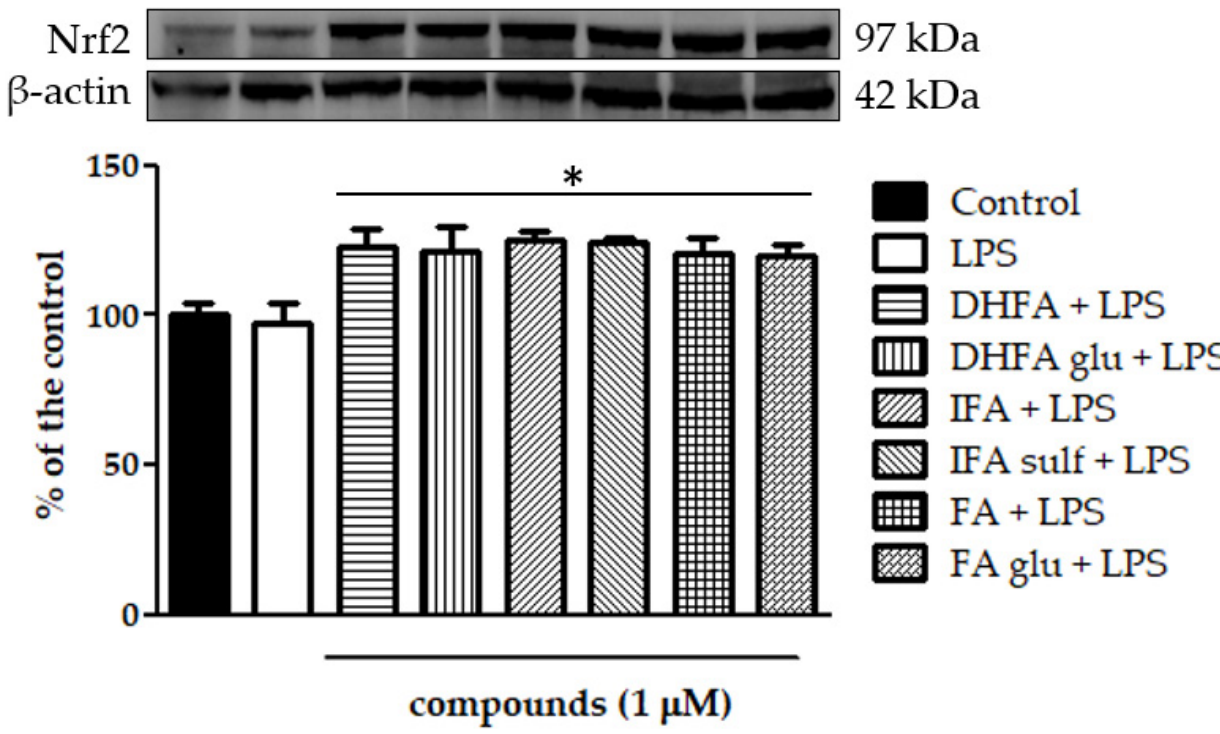
Figure 10. Level of Nrf2 dosed by Western blot and reported as a percentage of the control in Caco-2 cells treated with LPS (1 µ g/mL) for 48 h and pretreated for 30 min with FA, DHFA, IFA, FA glu, DHFA glu, and IFA sulf (1 µ M) preceding LPS co-exposure. Control and LPS groups were pretreated with an equivalent volume of methanol. Each column represents the mean ± SD of independent experiments ( n = 6). Significant differences among groups are described using different superscript symbols; * = significant vs. control ( p < 0.001) and LPS ( p < 0.001). Representative WB picture of the experiment is shown. β -actin detection was used as a loading control for each sample.